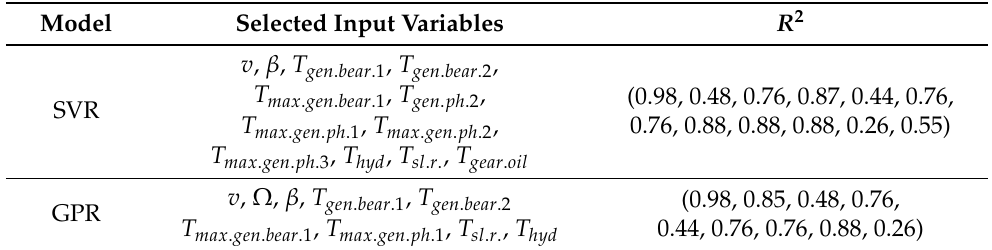
Table 1. Input variables selection for the SVR and GPR and coefficient of determination with the power P .